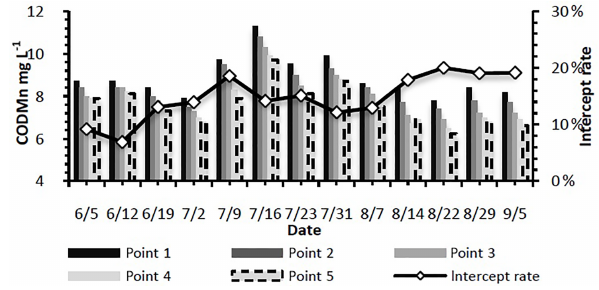
Figure 6. Change laws of the permanganate